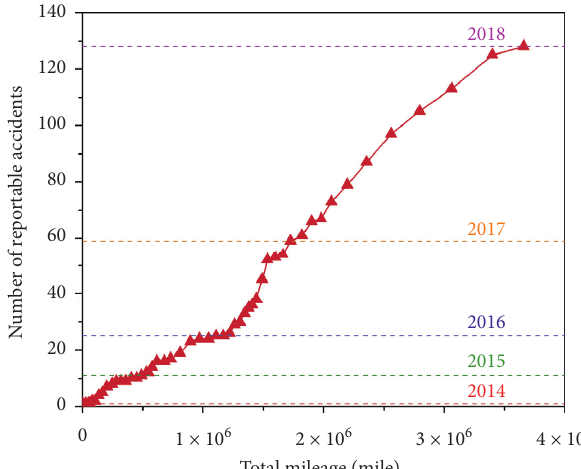
Figure 6: Relation between cumulative accidents and cumulative autonomous miles. (The data shown in this figure are reported by the manufacturers as of April